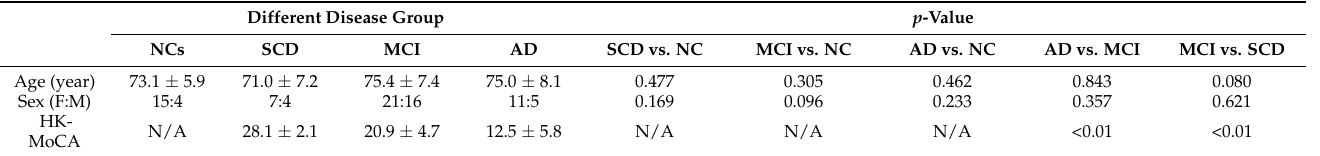
Table 1. Demographic and clinical